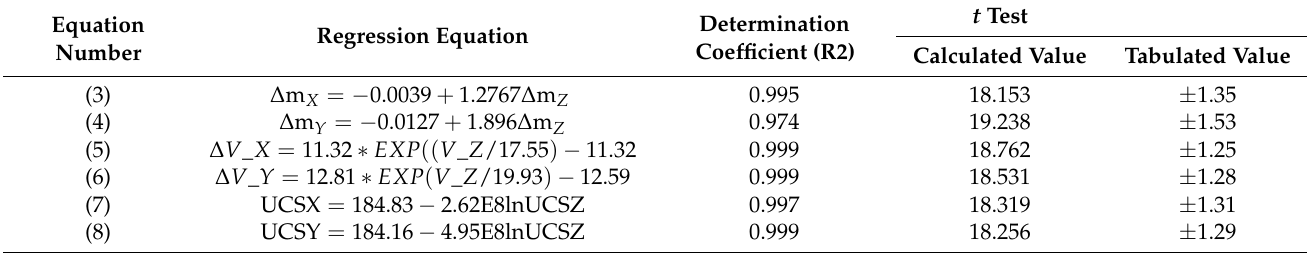
Table 2. The analyses results by t